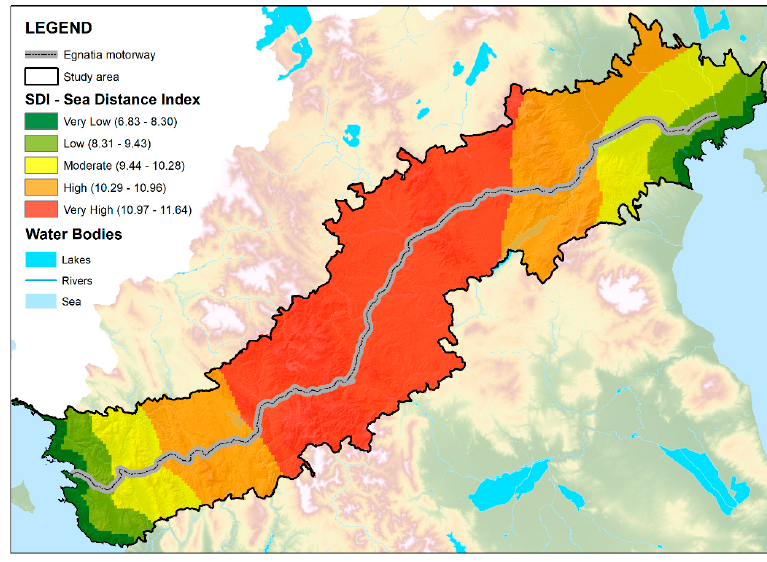
Figure 5. Spatial distribution of the SDI (Sea Distance Index).